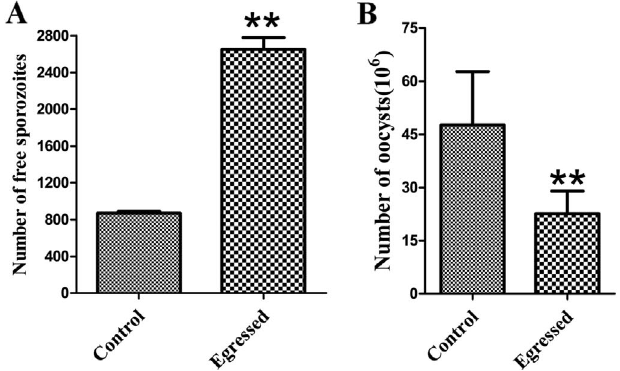
Figure 6. Decreased virulence in egressed parasites . Free parasites were collected after egress and counted using blood cell counting plates. (A) Egressed parasites were added to freshly prepared PCKs and incubated for 12 h; free sporozoites were suspended in 500 l L DMEM, and 10 l L suspensions were analyzed by fl ow cytometry after incubation. Data are means ± SEM of fi ve replicates, representing three independent experiments. ** p < 0.01. (B) Six birds were infected with egressed parasites (2 (cid:1) 10 4 ) via the cloacal route. Oocyst output per bird was quanti fi ed using a MacMaster chamber at 6 – 9 days after infection. Bars indicate means ± SEM. ** p <